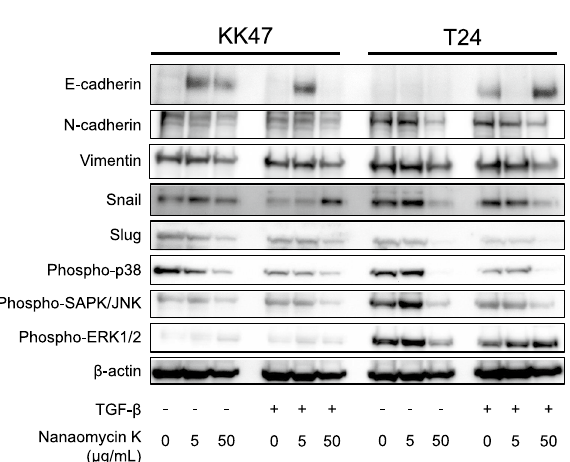
Figure 3. Gene expression of EMT markers induced by nanaomycin K in vitro. KK47 and T24 cells were treated with 5 µg/mL nanaomycin K with or without TGF-β in vitro for 48 h and the gene expressions of E-cadherin, N-cadherin and vimentin were determined by real time RT-PCR. Control cells were treated with DMSO (vehicle control) and mRNA levels were standardized by the expression levels of control gene β-actin (n = 3, average ± SE bars, * p < 0.05, ** p < 0.01).